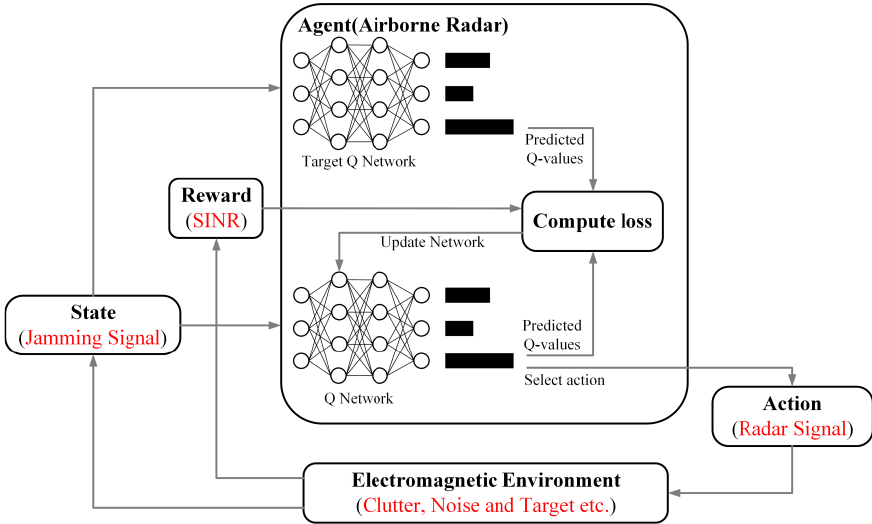
Figure 6. Block diagram of the radar intelligent anti-jamming based on the duelling double deep Q network (D3QN).